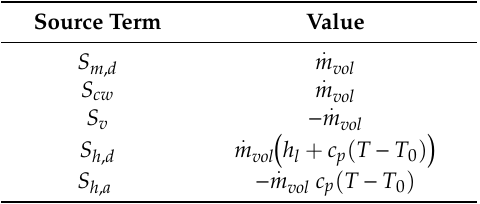
Figure 2. ( Left-Top ) Top view of the computational domain, illustrating the airflow direction (in orange), desiccant flow direction (in yellow), and Spacer (in green). ( Right) shows a longitudinal cross section where the purple line indicates (dimensions are in mm). In this view, the air domain is in orange, spacer is in green, desiccant domain is in yellow, and blue shows the frame. ( Left-Bottom ) illustrates one magnified section of the longitudinal cross section, showing two fluid domains separated by membranes (in red), spacer, and outer surface of mini-tubes (in grey), where the desiccant flow is normal to the airflow. Table 1. Source term used in the governing equations.